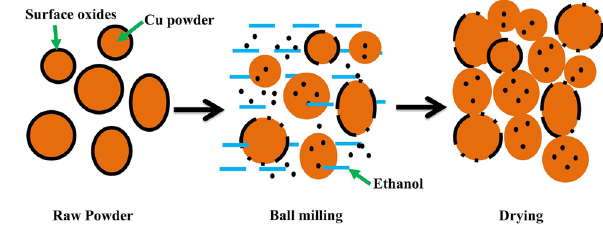
Figure 7: Room temperature engineering strain vs stress curves of as - extruded samples. Figure 8: Schematic of ball milling on powder